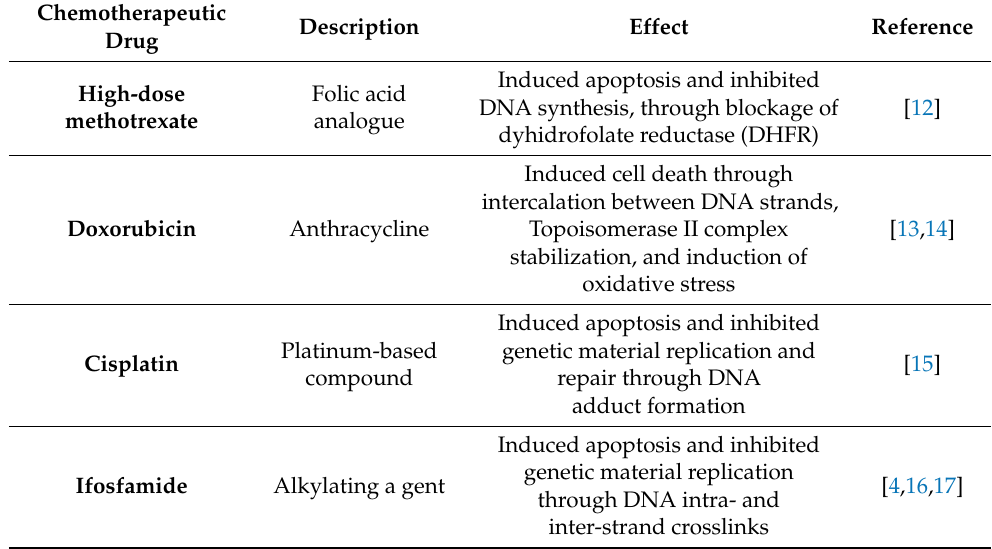
Table 1. Chemotherapeutic drugs used in osteosarcoma